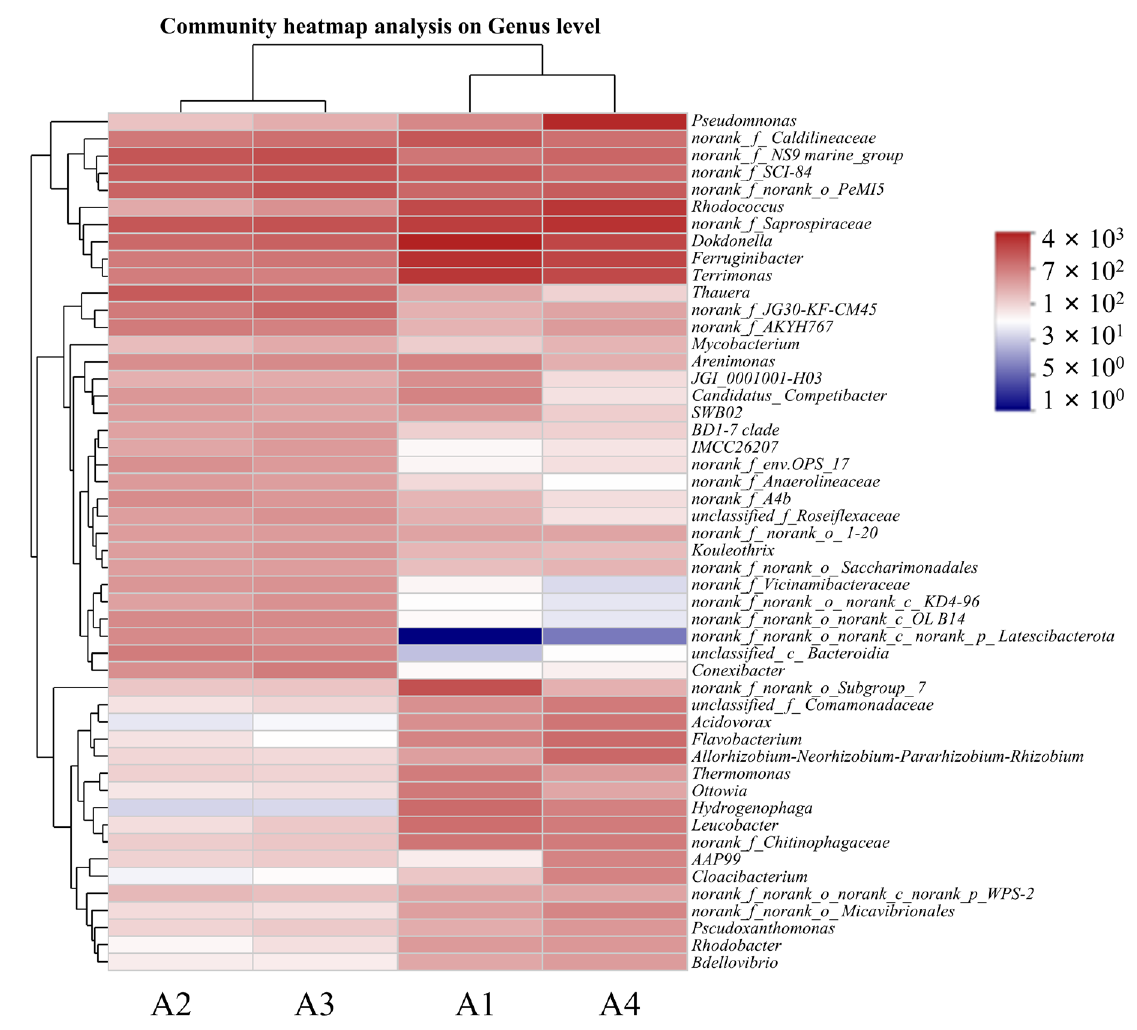
Figure 6. Evolution of microbial community structure in genus level (only the top 50 genera are shown, and the data are displayed by log 10 number. The phyla corresponding to the different genera are marked by different colors). Table 3. Proportion of functional bacteria in different floating islands .